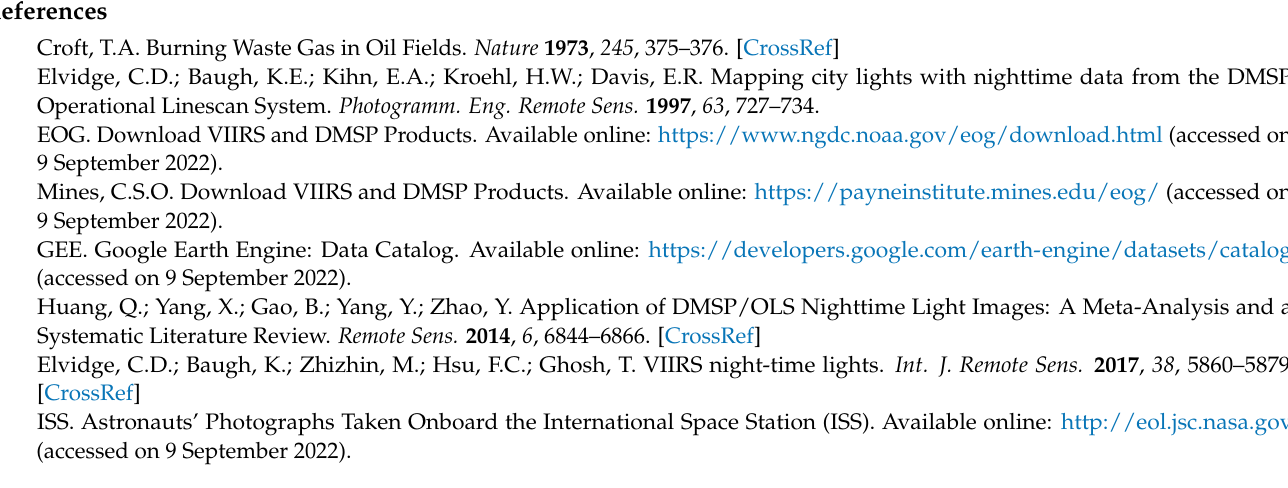
Table S3: Socio-environmental SDG indicators; Table S4: Indicators used to calculate the Social Gap Index (SGI) in 2010 and 2020; Table S5: SGI and average radiance in the localities across the AOI. Refs. [53,56] are cited in